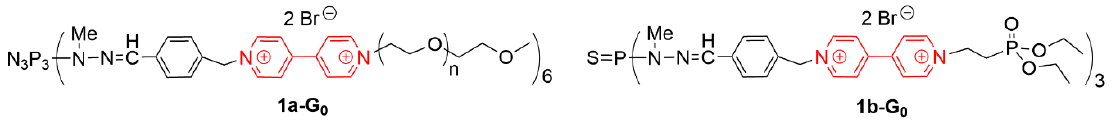
Figure 2. Small viologen dendrimers having anticancer properties.